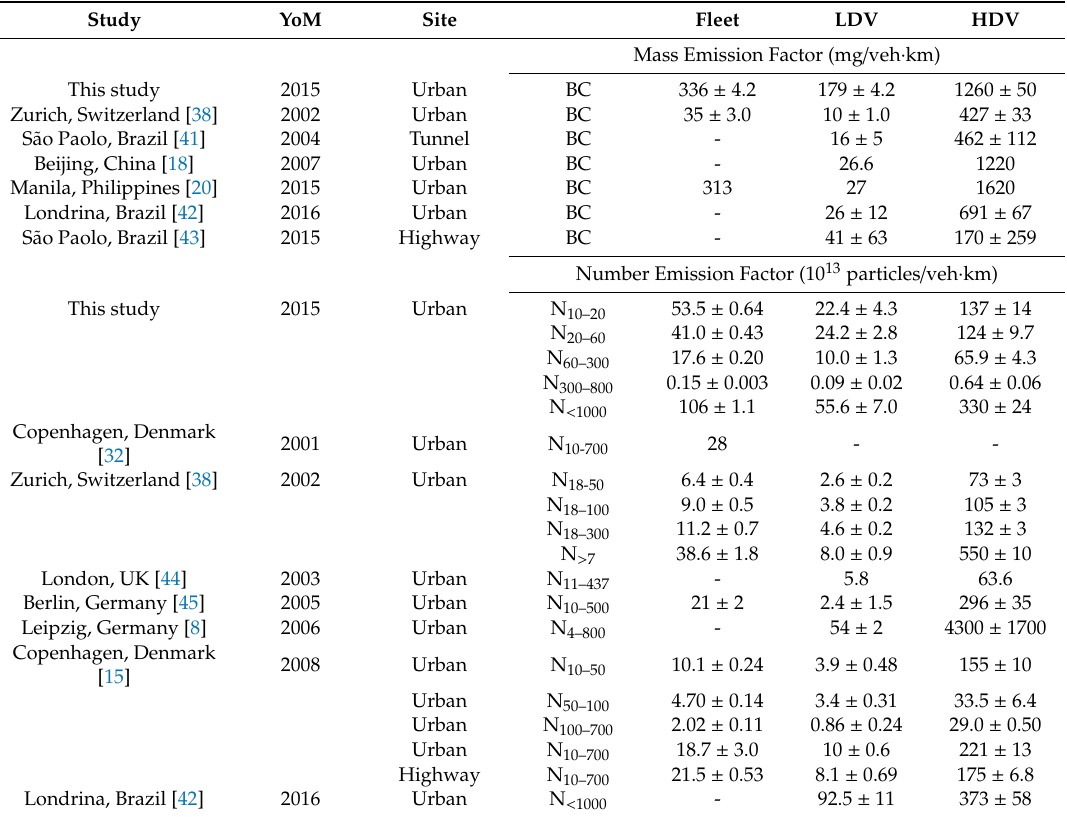
Table 1. Summary of particle number (PN) and BC mass emission factor (EF) compared to values from literature. Note that in case of Manila, column for heavy-duty vehicles (HDV) represents the EFs of public utility jeepneys (PUJs). Results for passenger-car like vehicles, which include light-duty vehicles (LDV), were compared with published emission factors of LDVs. We present results as mean EF ( ± standard error) and mean EF ( ± standard error or standard deviation) for other studies. YoM—year of